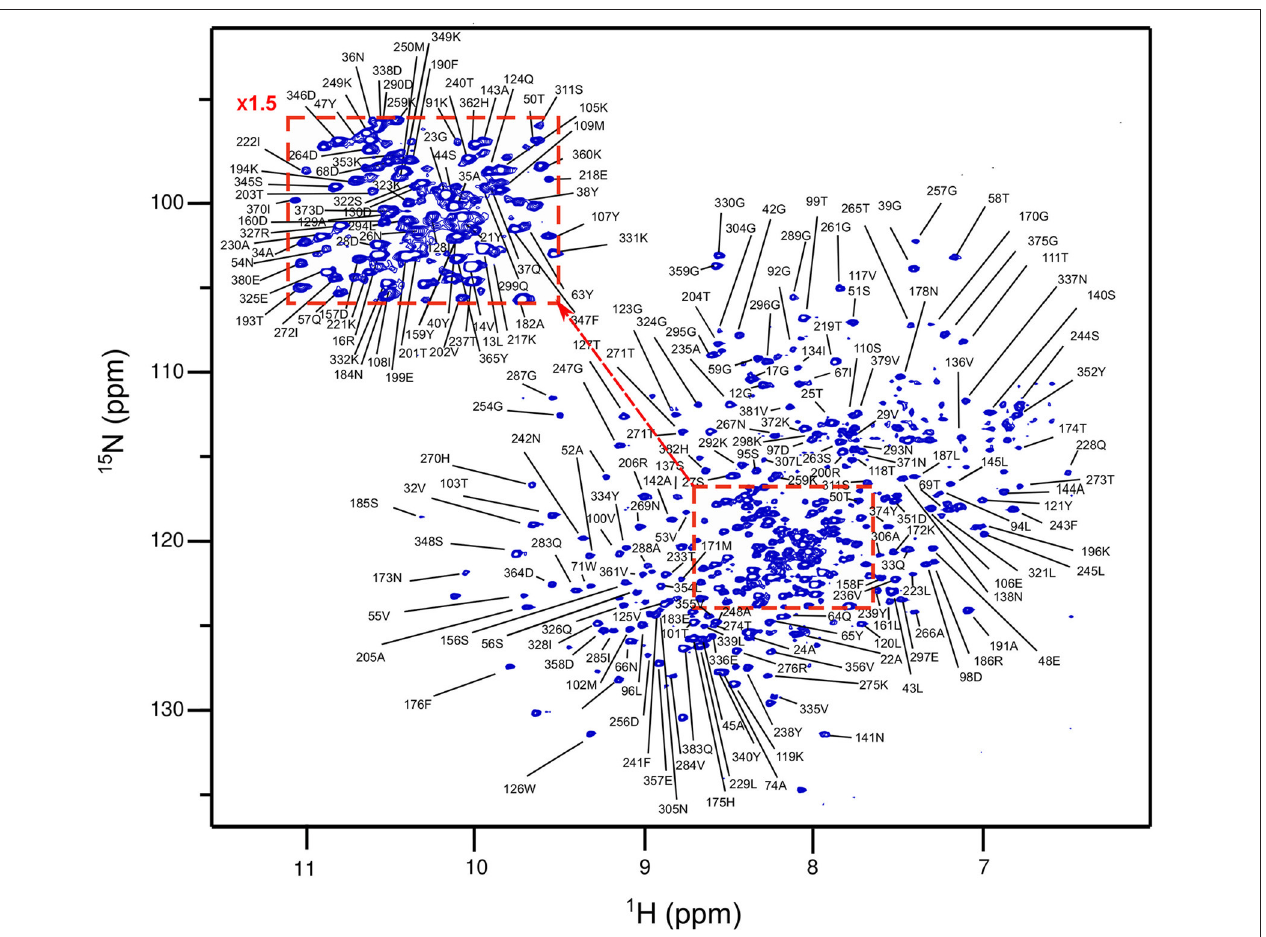
FIGURE 4 | Assignment of the amide resonances in PBP4. Display of the 1 H, 15 N-BEST-TROSY spectrum of a PBP4 sample (800 µ M) in 100mM potassium phosphate buffer containing 300mM KCl and 5% D 2 O at pH 7.5, collected at 25 ◦ C on an 850-MHz spectrometer. Assignment of backbone amide resonances obtained from 3D experiments is reported. Only 92 over 321 detected amide resonances remained unassigned due to the low sensitivity in 3D